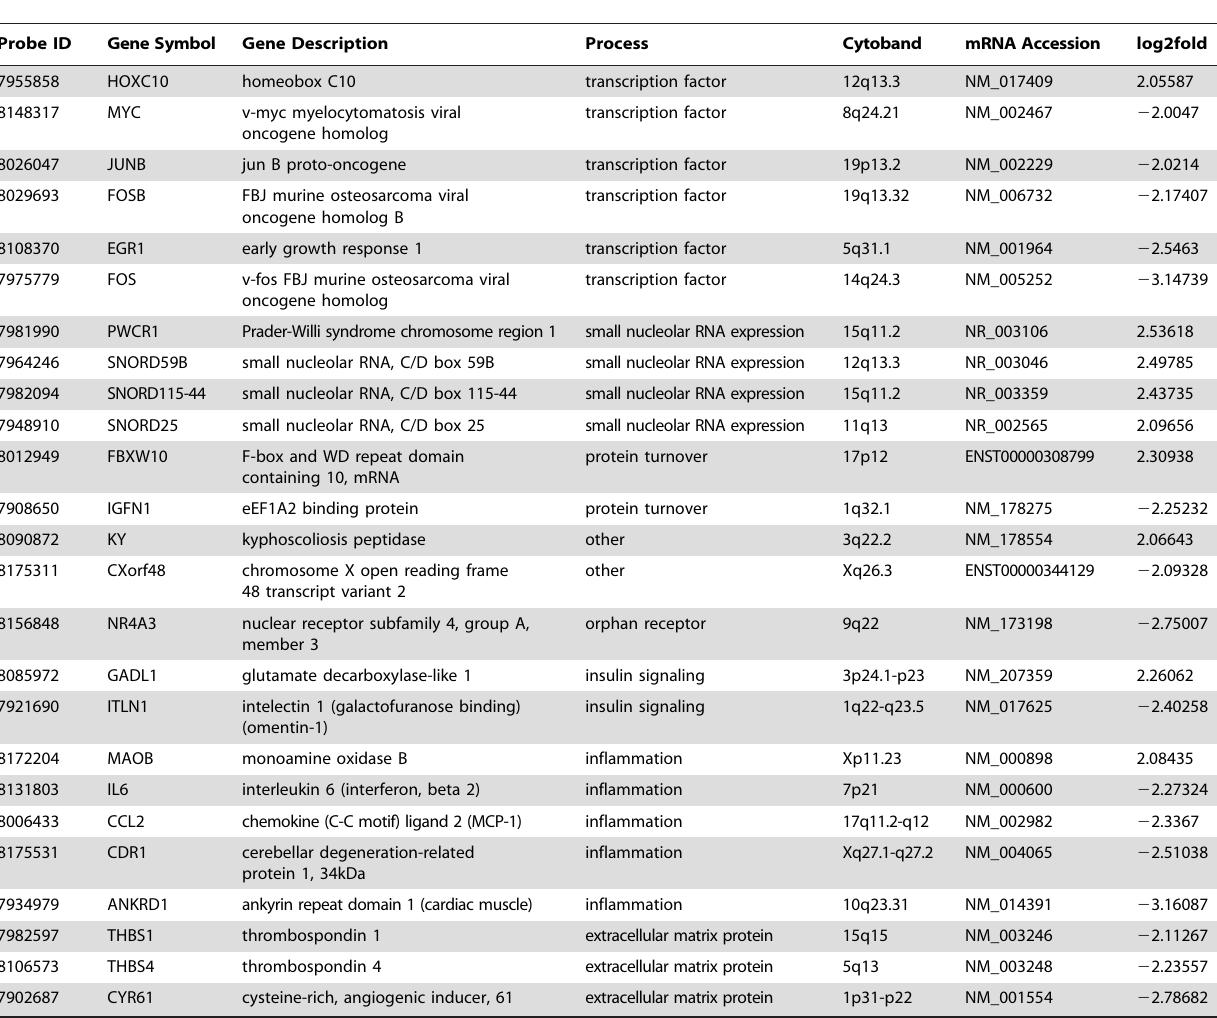
Table 3. Genes changed $ 4 fold (log 2 base $ 2) between 6 and 0 months no omentectomy.